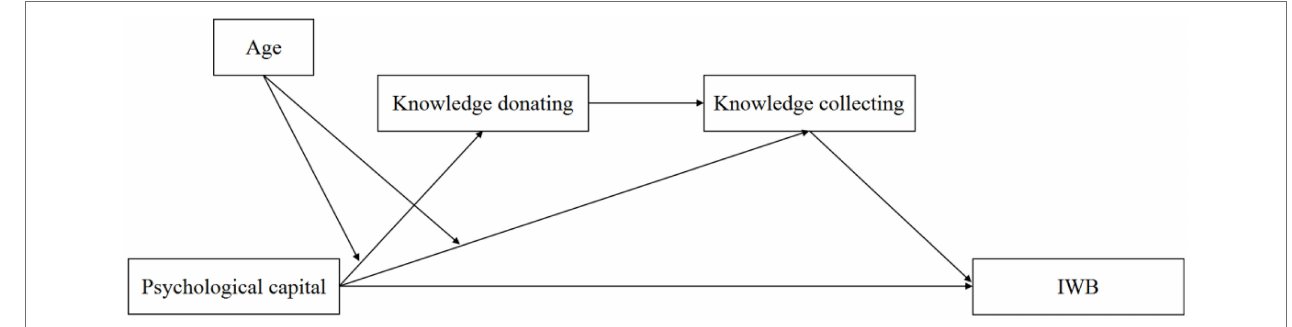
FIGURE 3 | The final